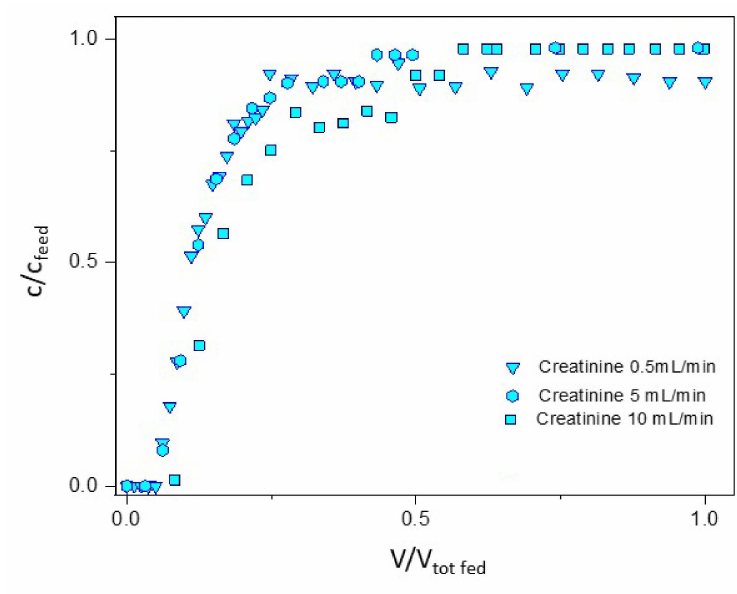
Figure 9. Breakthrough curves of creatinine for the MMMAs cartridge in contact with a mixture of toxins at the three different feed flow